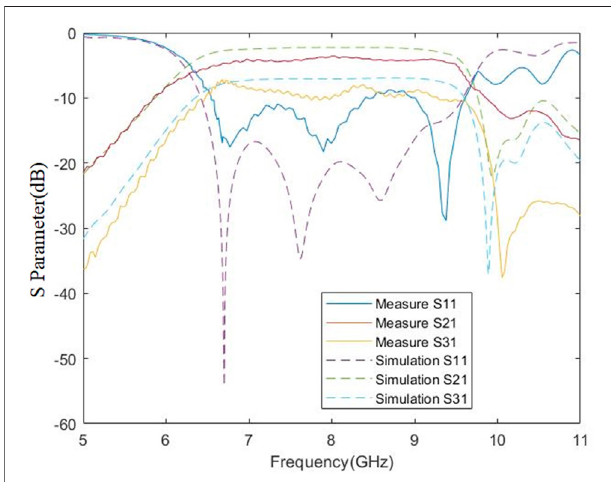
FIGURE 8 | Comparison of simulated and measured